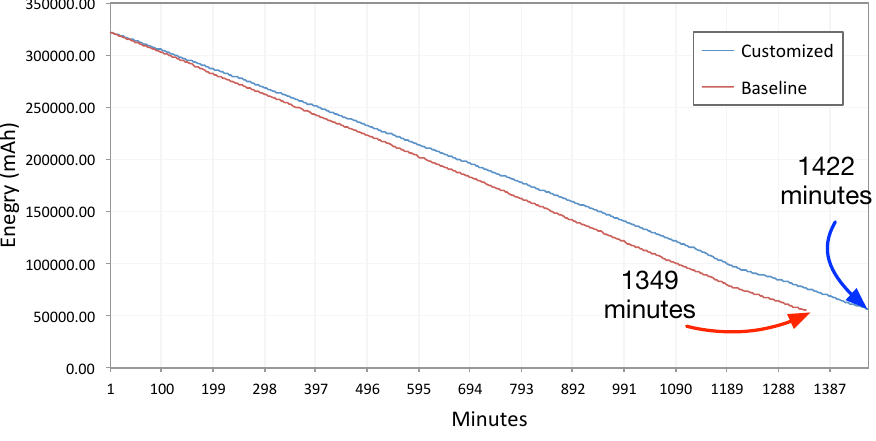
Figure 7. Battery discharge rate comparison between baseline ambient light sensing and our proposed sensing method. The test condition is set to discharge the battery from 100% to 1%